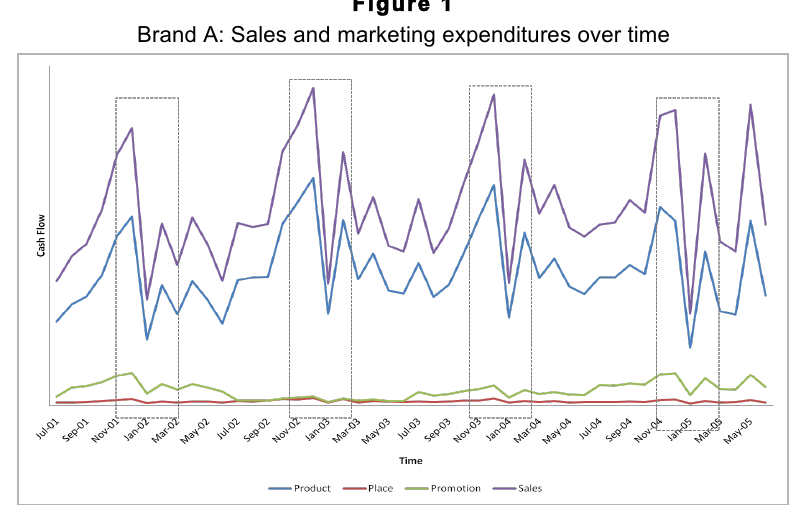
Brand A: Sales and marketing expenditures over time